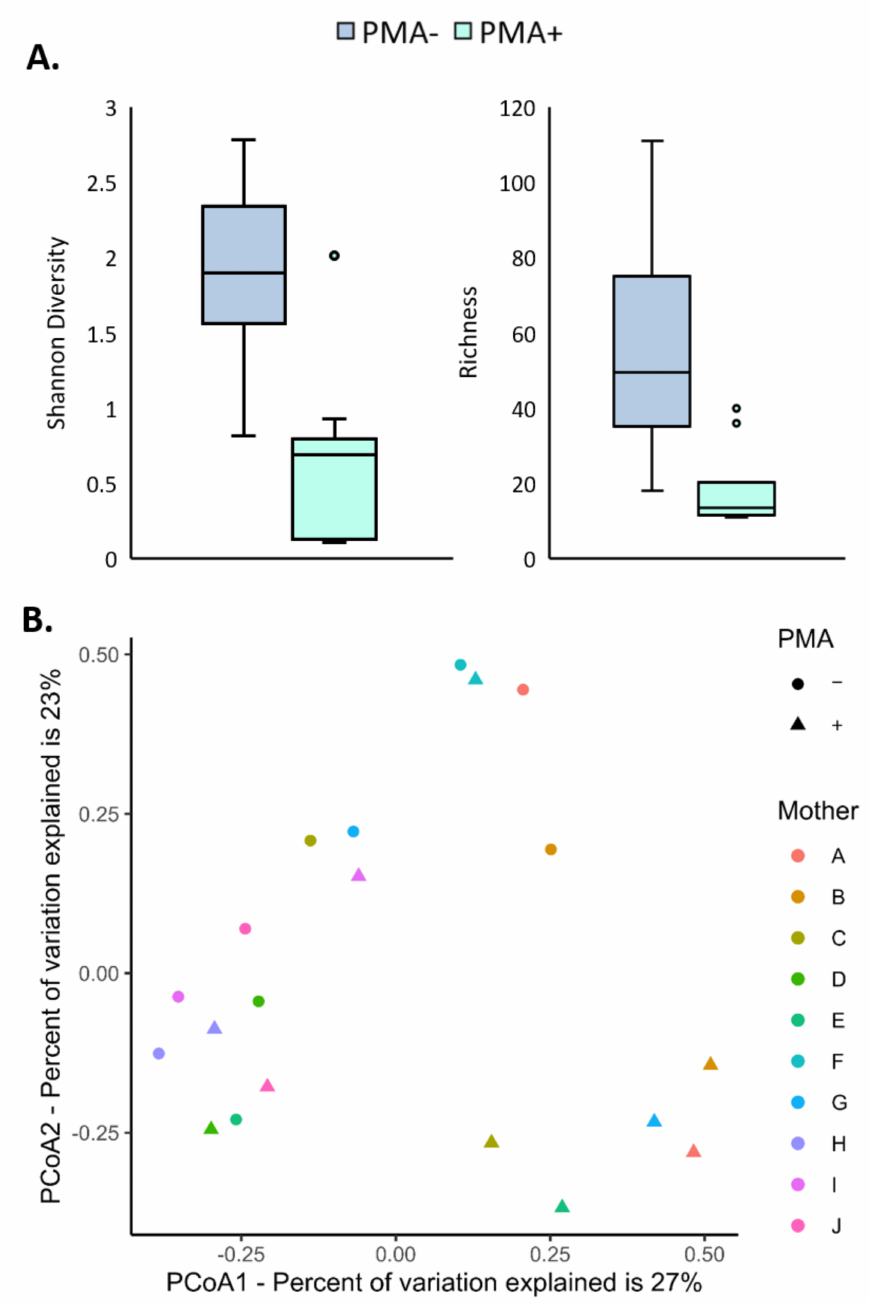
Figure 2. ( A ) Shannon diversity and richness of PMA-treated human milk samples was significantly lower than untreated samples (Shannon diversity: linear mixed model, p = 0.0188; richness: linear mixed model of log-transformed data, p = 0.0001). Boxes are interquartile range, whiskers are range, and inner lines are medians. Light blue boxes are PMA-treated samples, while dark blue boxes are untreated samples. ( B ) PCoA plot of Bray-Curtis distances of PMA-treated and untreated human milk samples. Different colors denote different individuals, while shape denotes PMA treatment status (triangle is treated and circle is